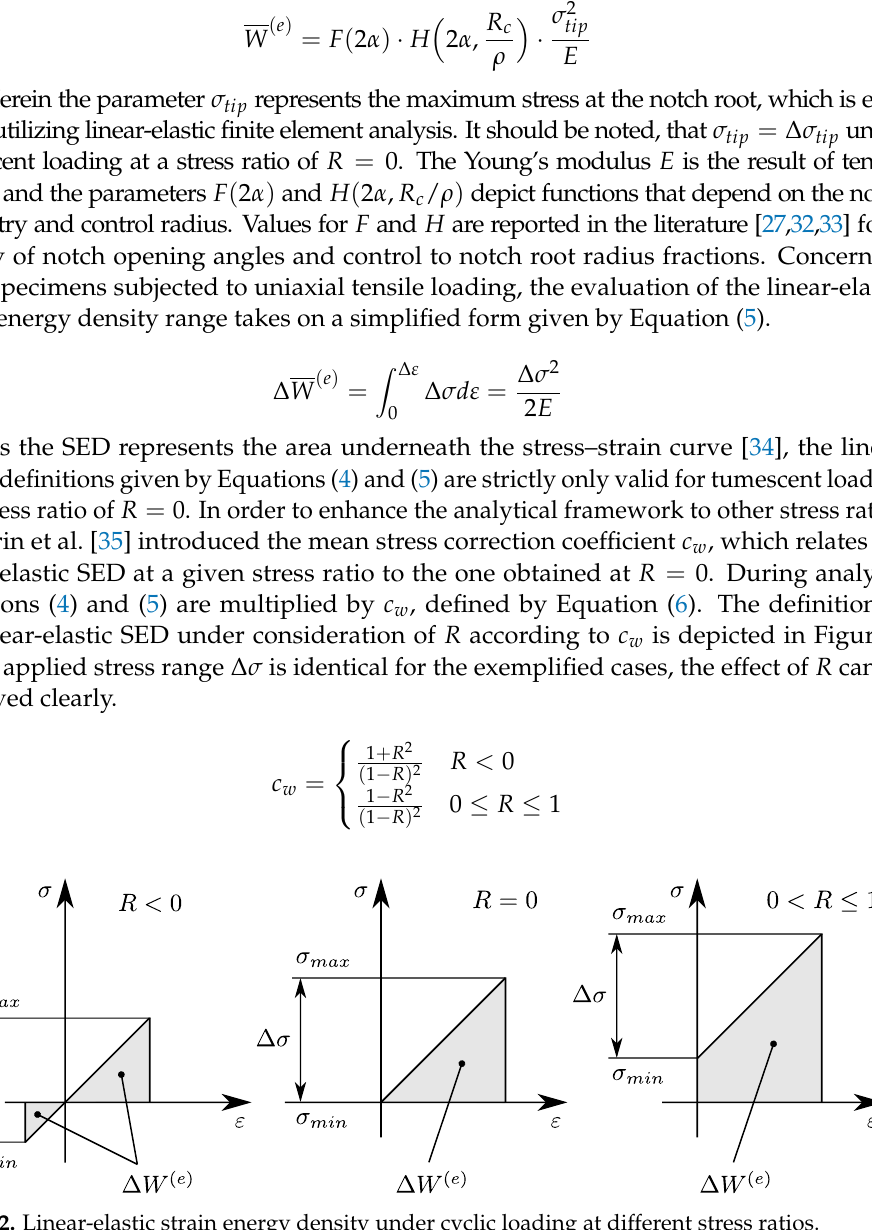
Figure 2. Linear-elastic strain energy density under cyclic loading at different stress